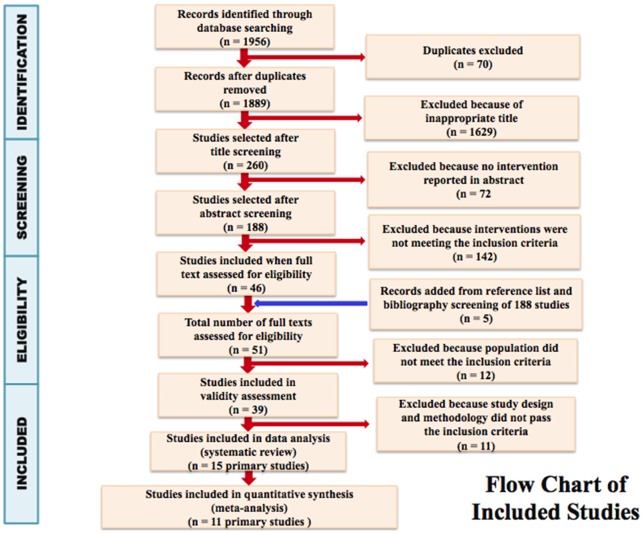
PRISMA flow diagram.